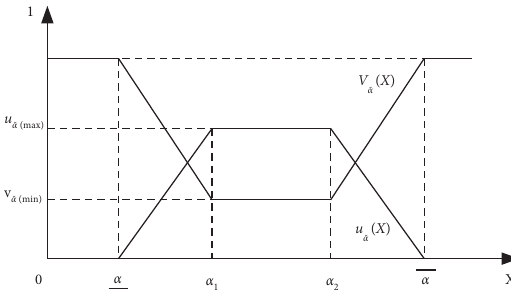
Figure 1: q -ROTrFN 􏽥 a � ( a,a